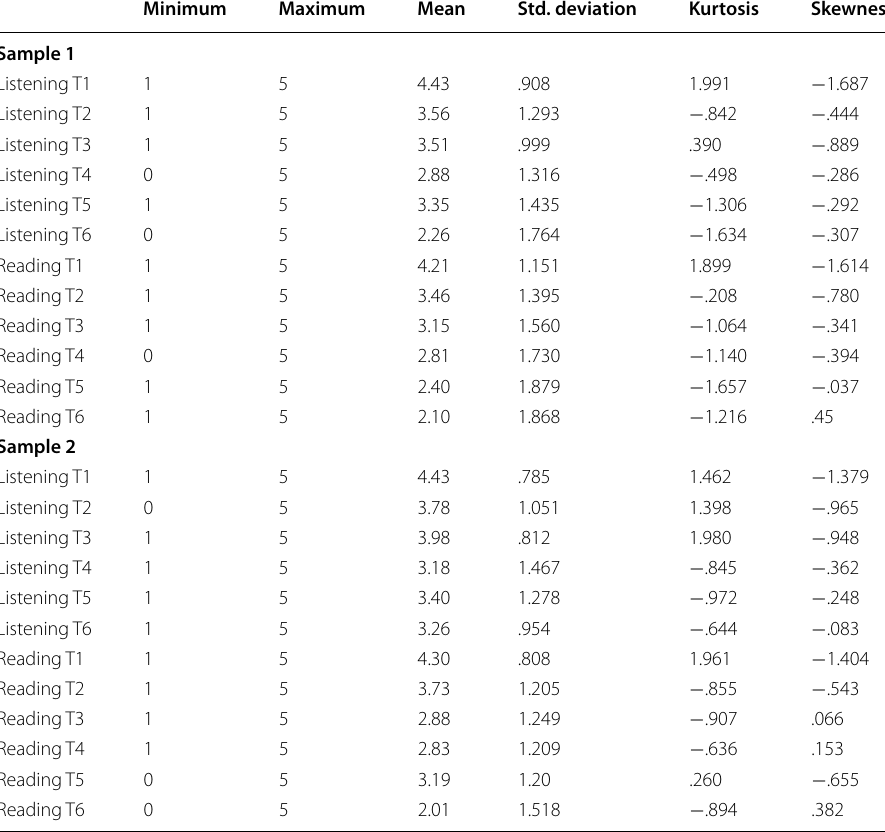
Table 2 Descriptive statistics of each sample